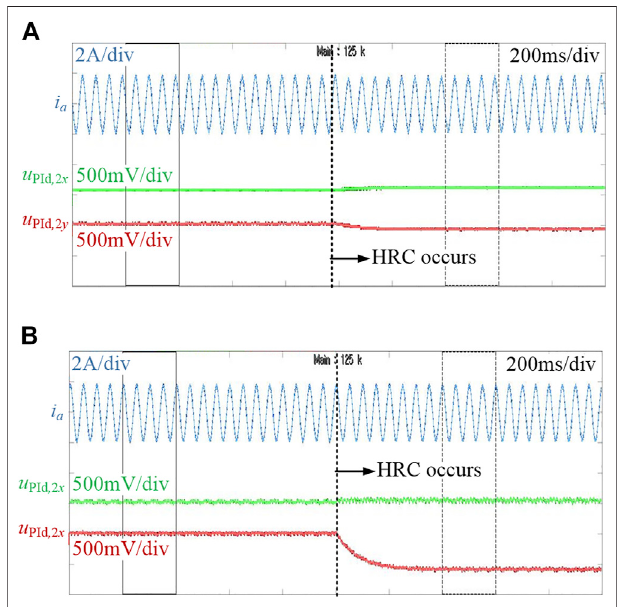
FIGURE 17 | Stator current, extracted u PId,2 x , and u PId,2 y of the PM machine. (A) K p = 1 and K i = 10; (B) K p = 30 and K i = 300.